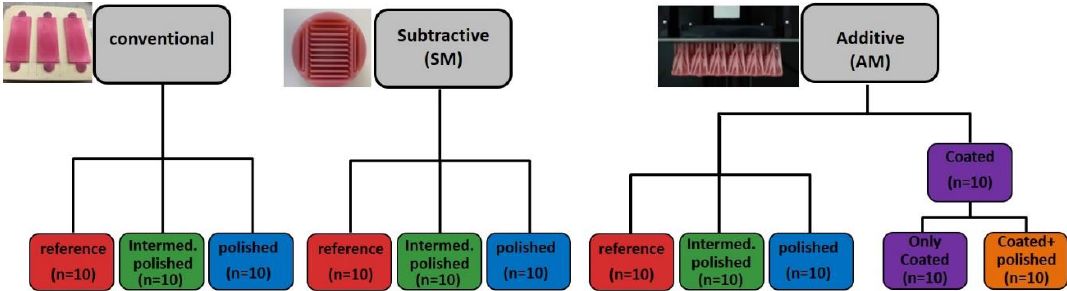
Figure 1. Study flowchart. Three different manufacturing approaches with various surface treatment protocols.